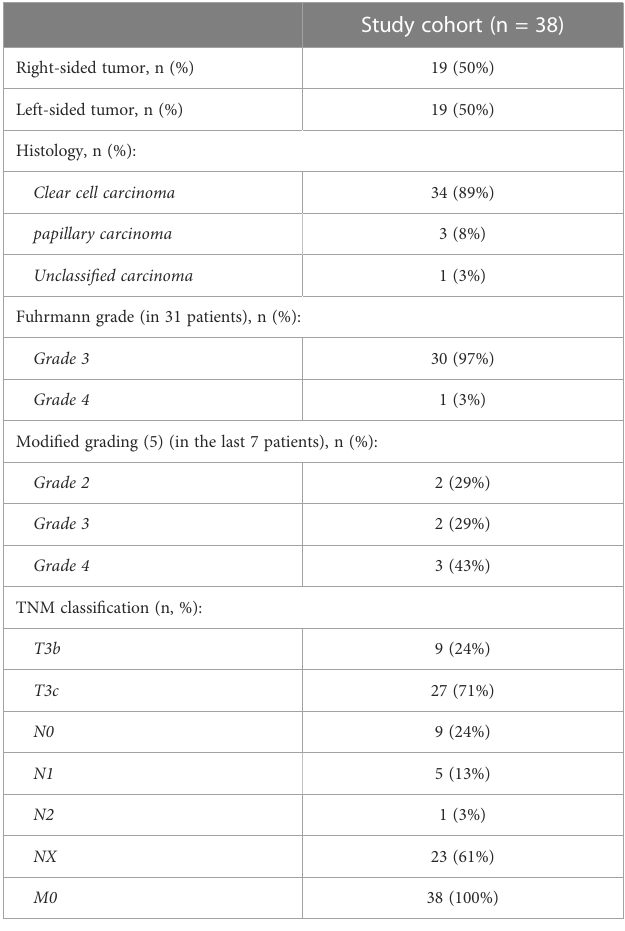
Study cohort (n = 38)